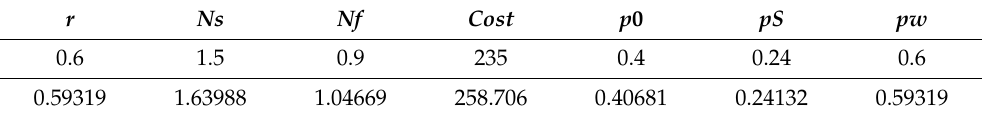
Table A1. The results for S = 1.